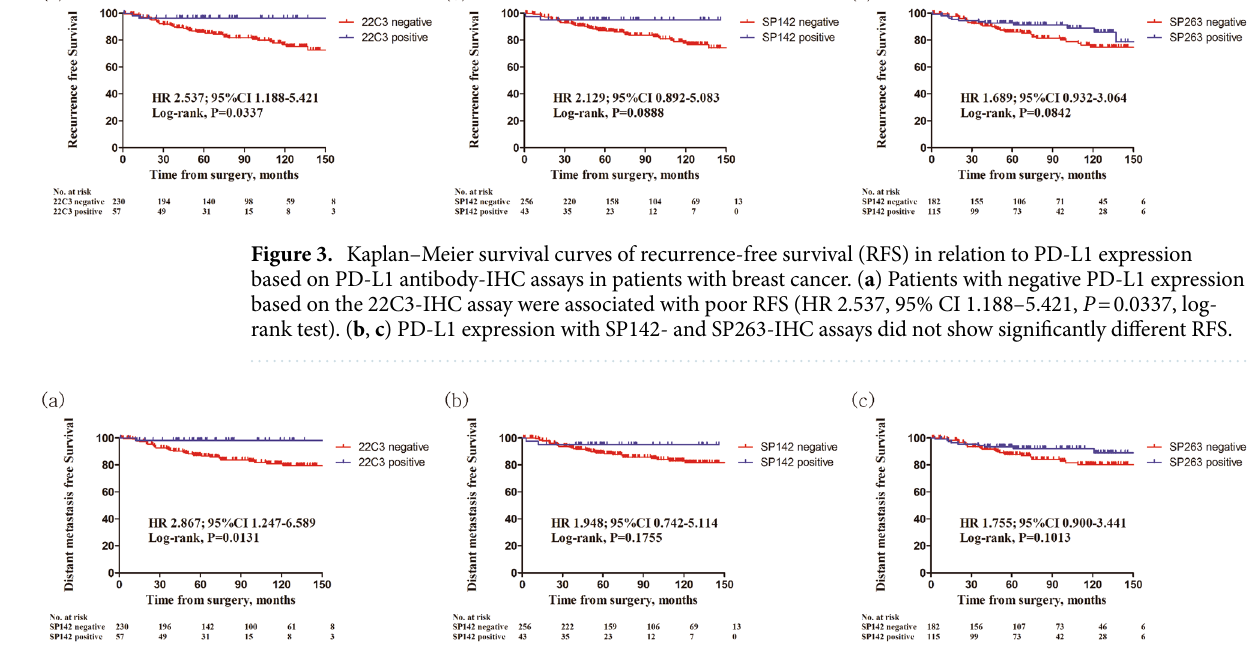
Supplementary Table 3. Positive PD-L1 expression using the SP263 antibody was associated with HG and higher Ki67, and negative PD-L1 expression using the SP142 antibody was related to lower AJCC stage. Otherwise, there was no statistical difference in the other clinicopathologic characteristics. Survival outcomes based on the PD-L1 expression according to each antibody utilized were compared for